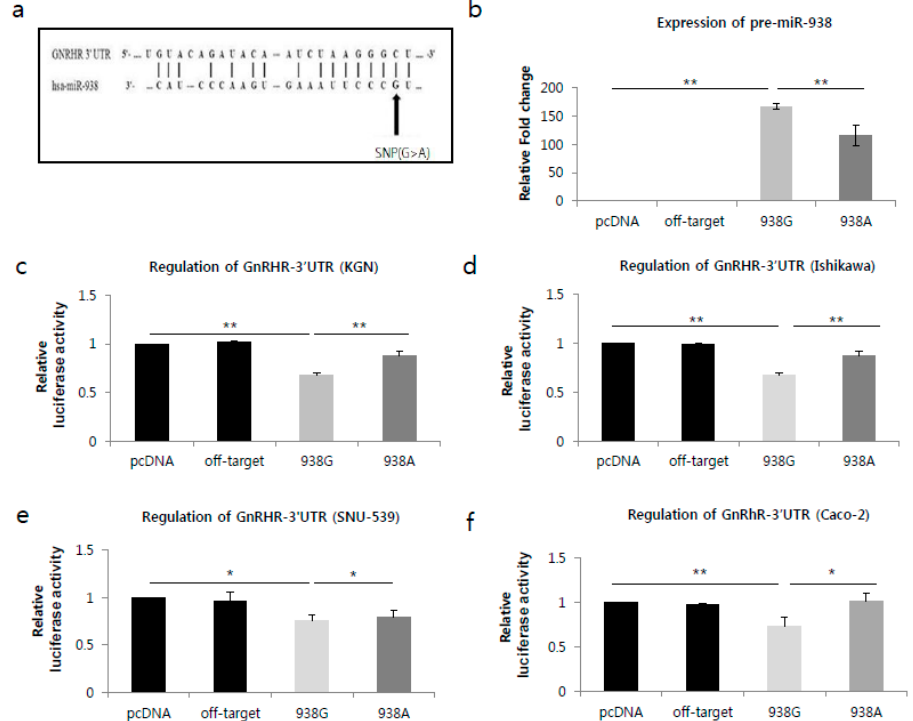
Figure 1. miR-938 targets the GnRHR mRNA through a targeting sequence located at the 3 ′ UTR. ( a )